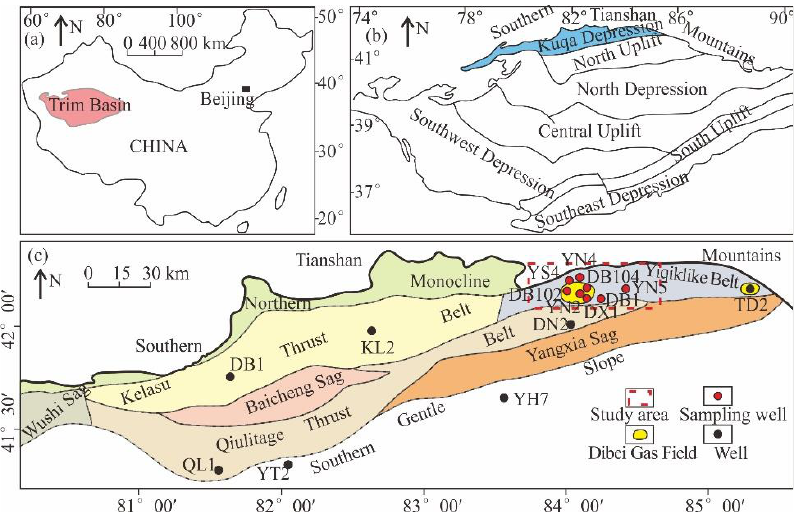
Figure 1. Tectonic units and location of Dibei Gas field in Kuqa Depression. ( a ) Location of Tarim Basin; ( b ) location of Kuqa Depression; ( c ) sample wells and structural outline of Dibei gas field in Kuqa Depression.